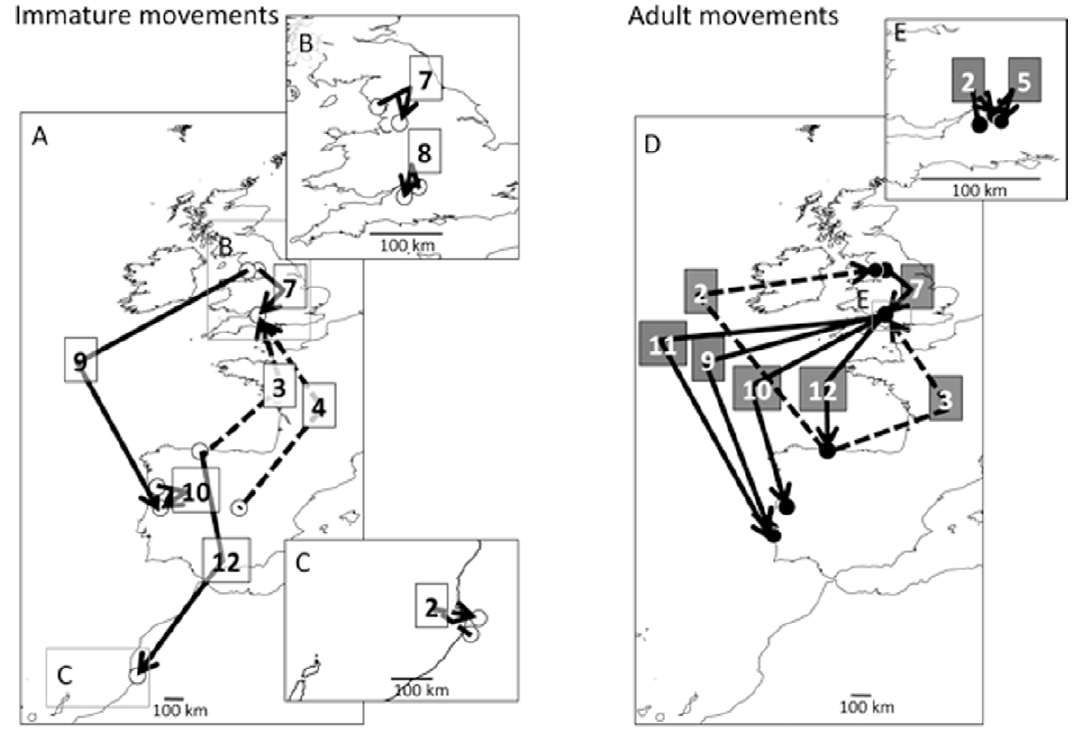
Figure 2. Examples of the most common movements observed across the population range. Median departure and arrival locations (circles) are connected by arrows indicating the direction of the movement. Numbers represent the month when the movement started (1 for January, up to 12 for December). A- Immatures long movements. B and C- Immatures short movements. D- Adults long movements. E- Adults short movements. Full line arrows, southward movements; dashed line arrows, northward movements.